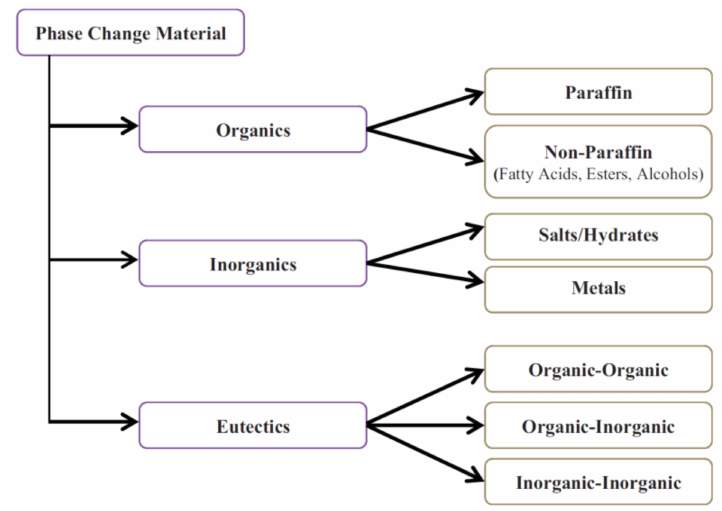
Figure 2. Classification of PCMs. Reprinted with permission from ref. [27]. 27 October 2021, Elsevier.